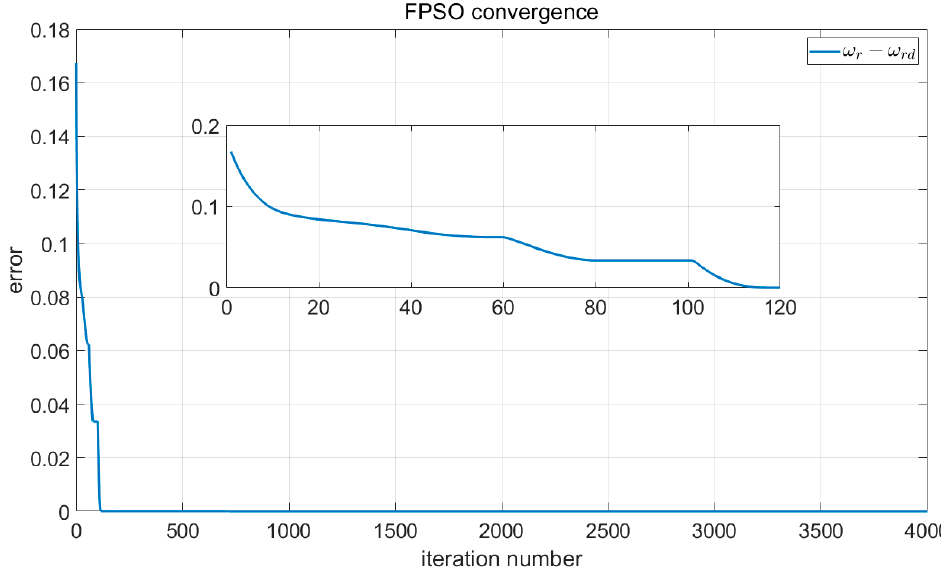
Figure 11. Convergence of the FPSO.